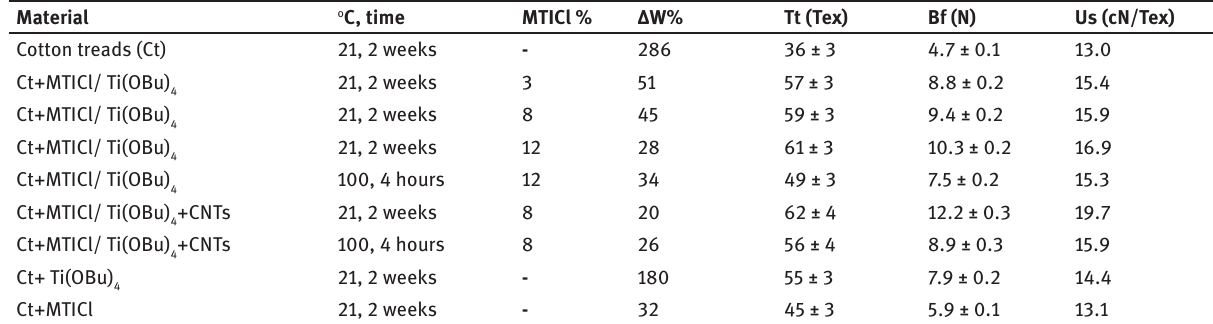
Table 3: Mechanical properties and dimensional stability of different cotton hybrids.